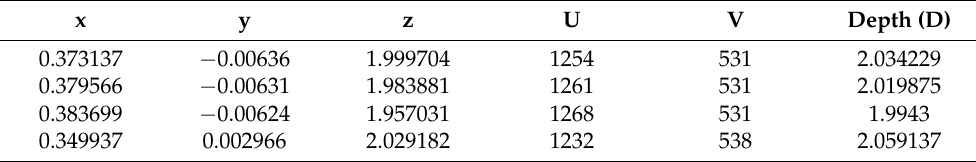
Table 2. Examples of 3D point cloud data and corresponding calculated depth value.